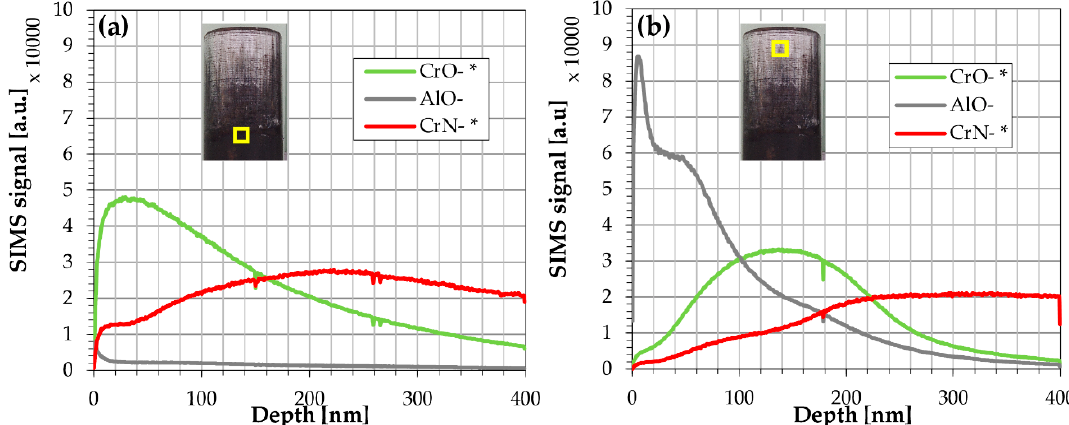
the locations of the depth profiling. surfaces and